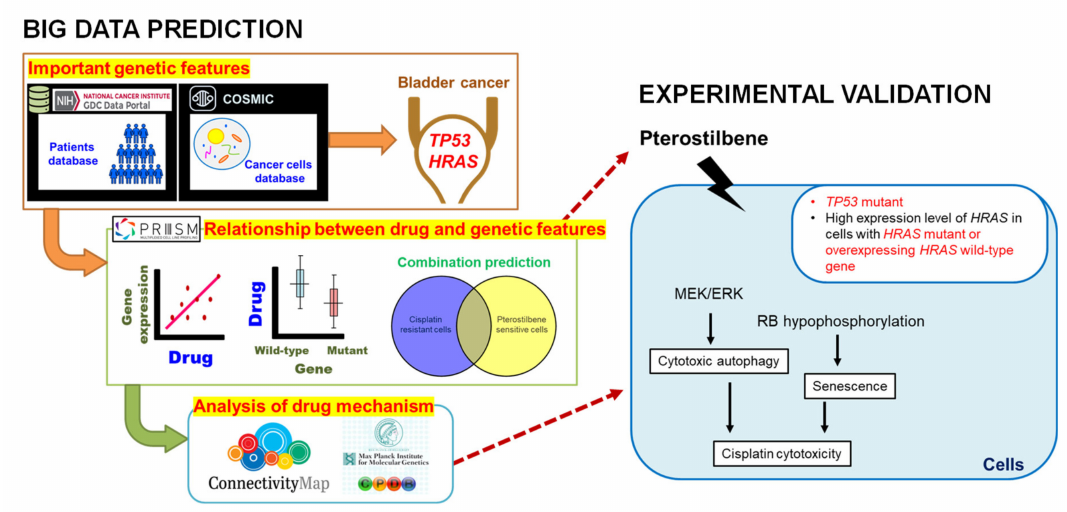
Figure 7. The e ff ect of pterostilbene on cisplatin-resistant human bladder cancers with oncogenic HRAS